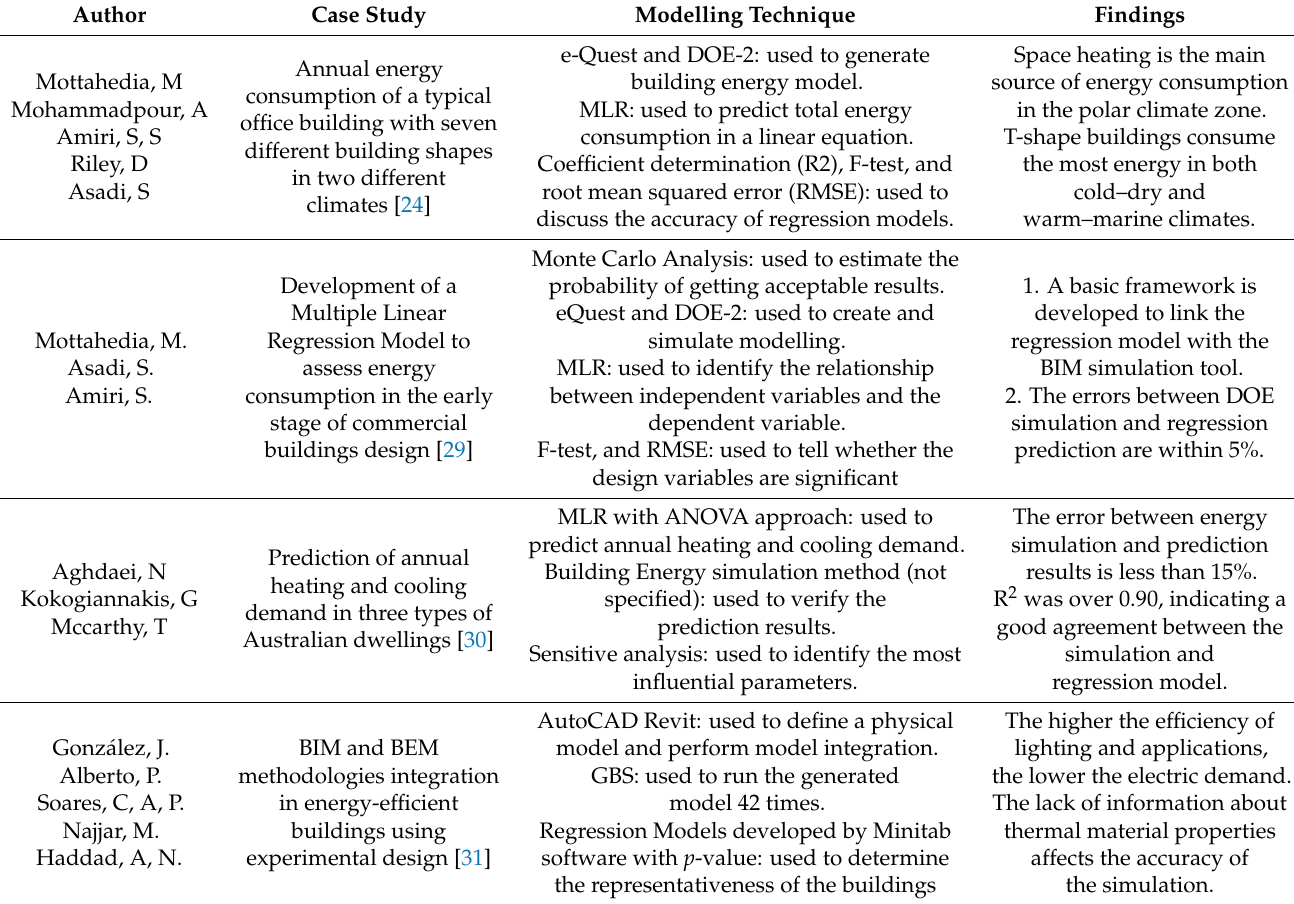
Table 2. Summary of case studies about regression analysis combined with BIM